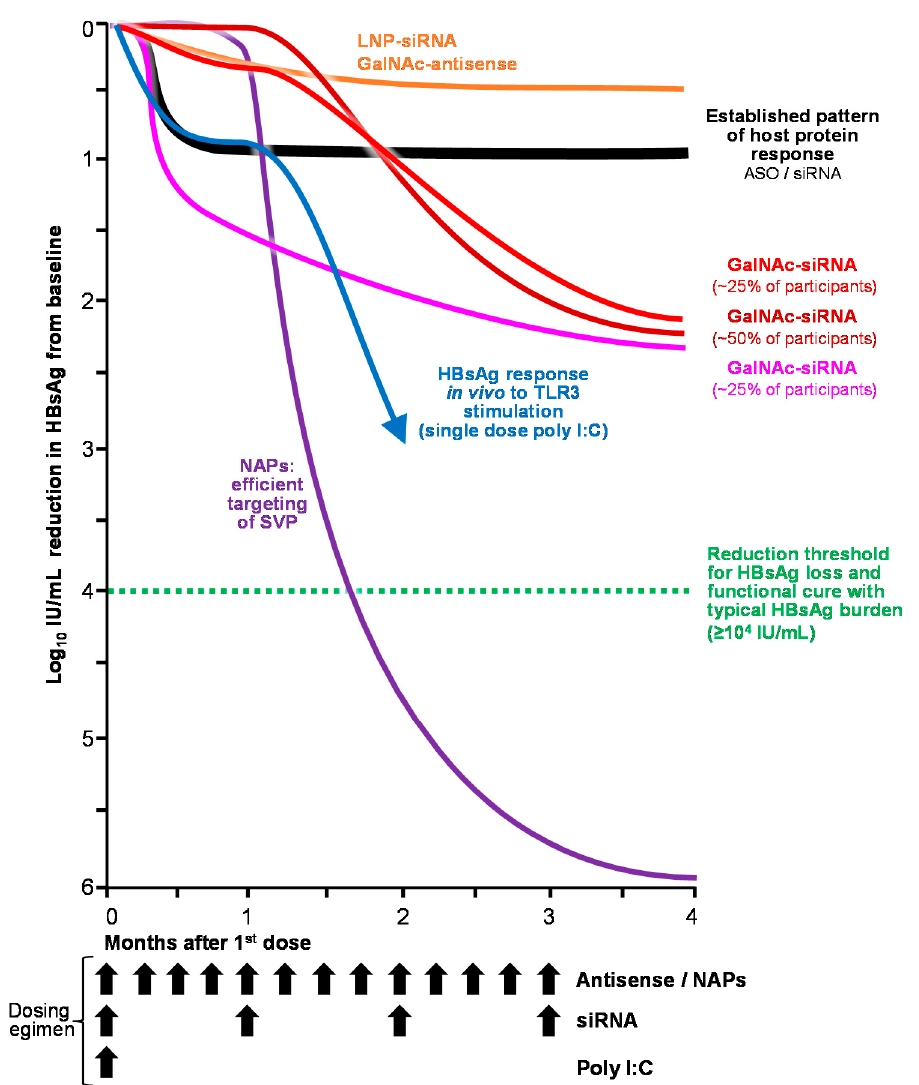
Figure 5. Relative impact on HBsAg response with oligonucleotide-based medicine in human chronic HBV infection. HBV